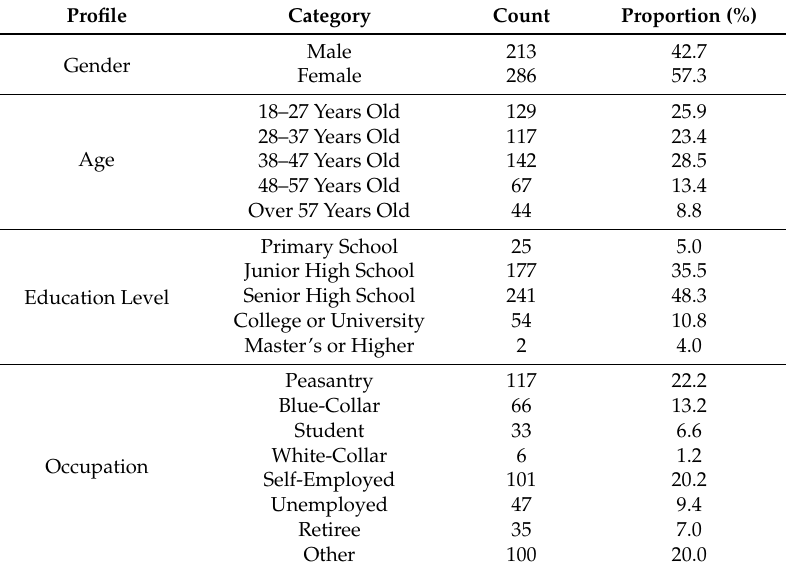
Table 2. Survey respondent